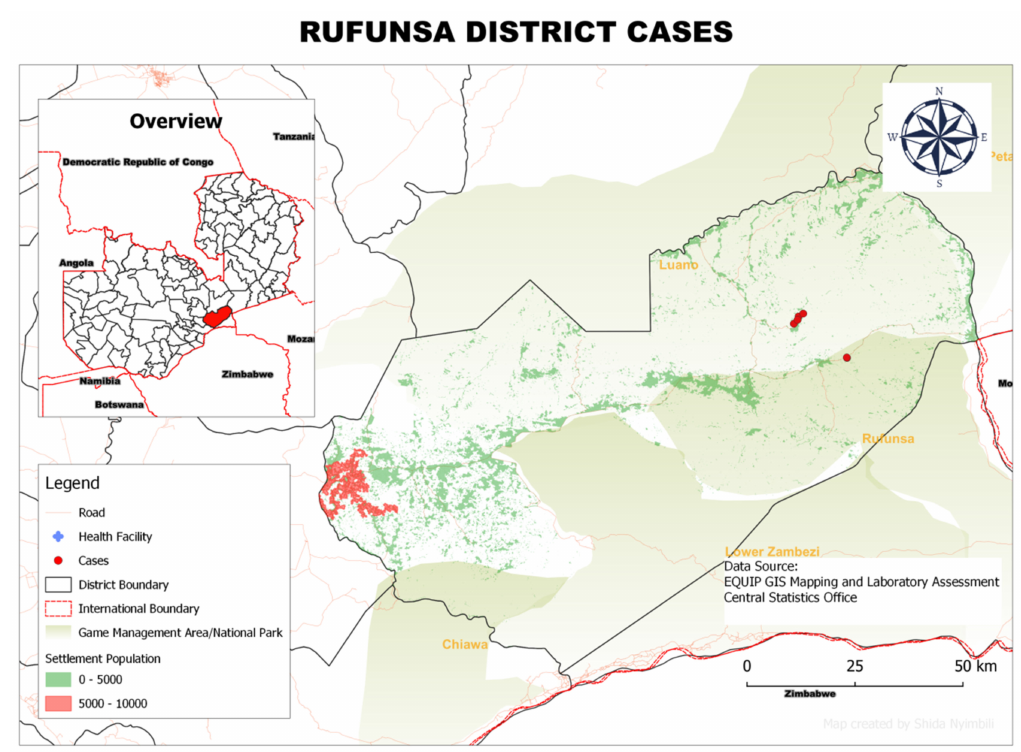
Figure 5. Spatial distribution of rHAT cases from 2004 to 2014 in Rufunsa District, Lusaka Province,